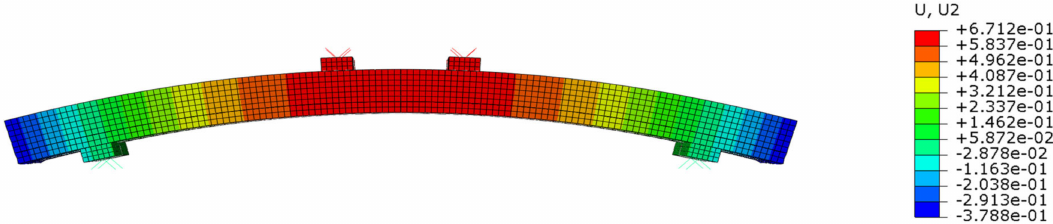
Figure 9. Effect of pre-stressing the